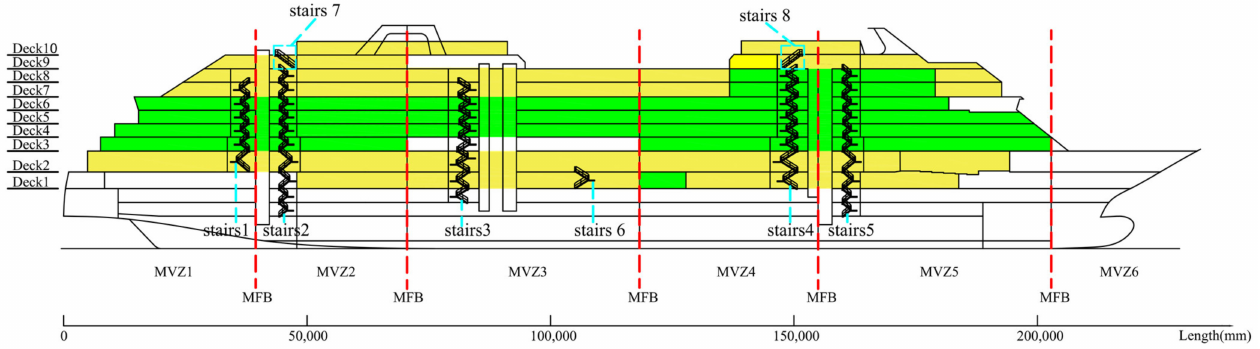
Figure 1. The space distribution of the cruise ship.